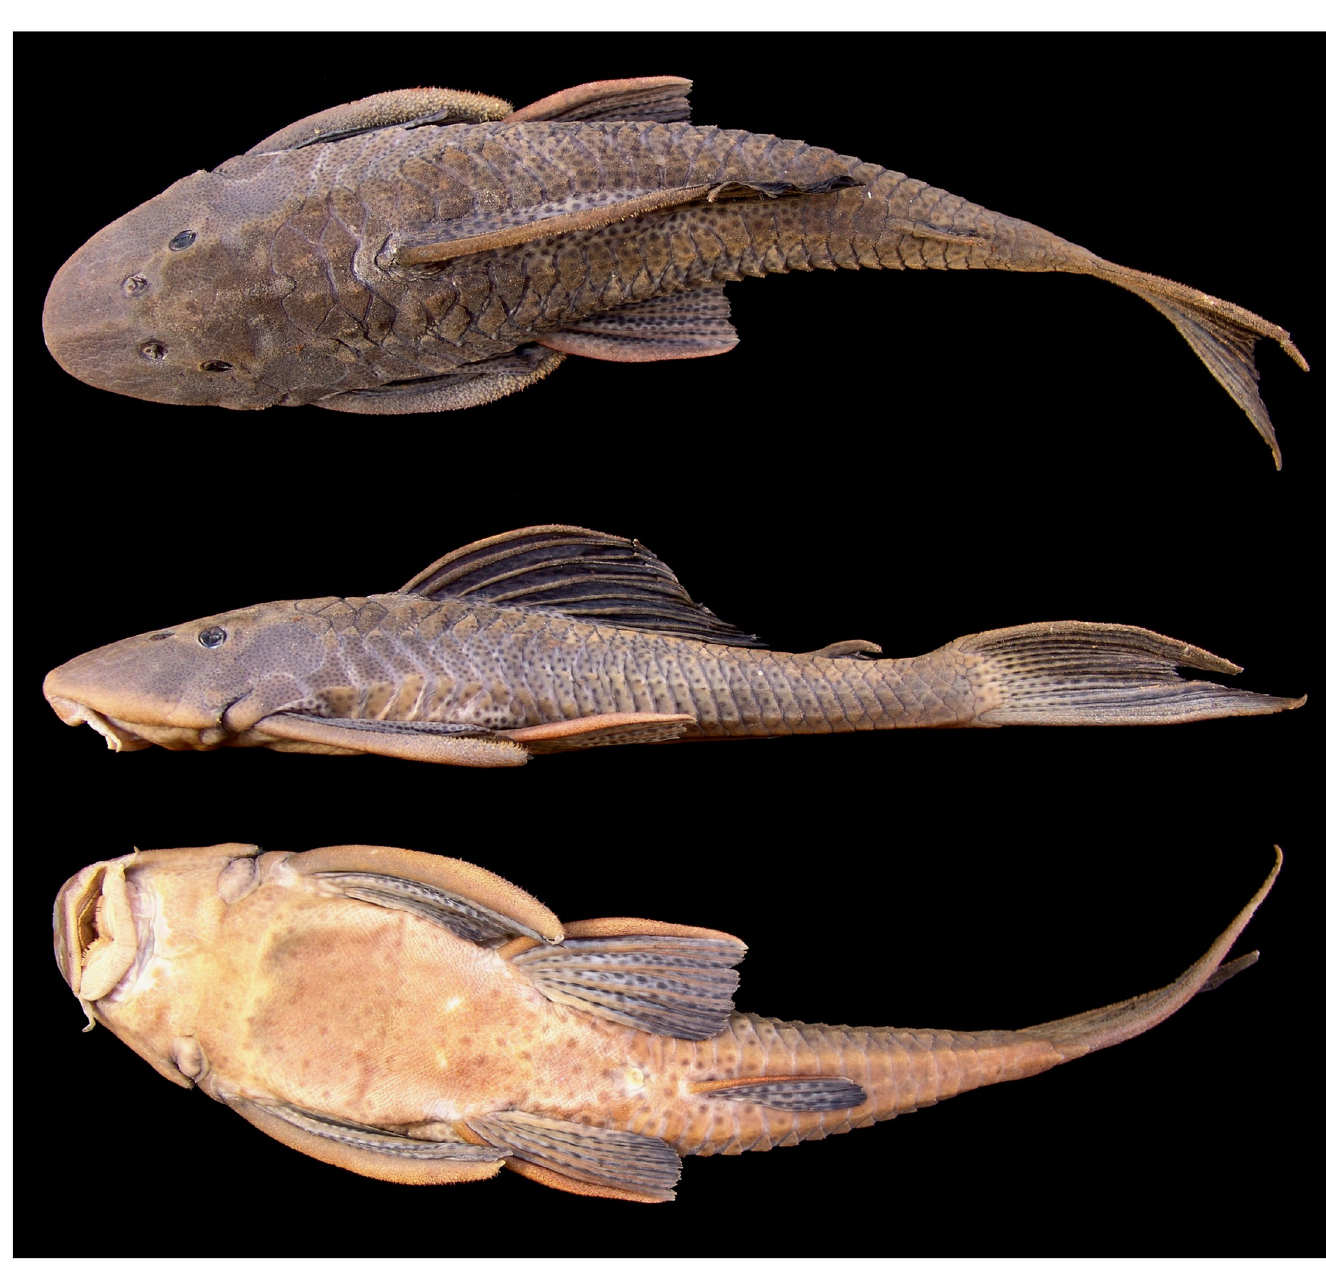
Fig 2. Hypostomus subcarinatus , MCNIP 1103, 249.5 mm SL. Lagoa da Pampulha, Belo Horizonte, Minas Gerais State, Brazil.